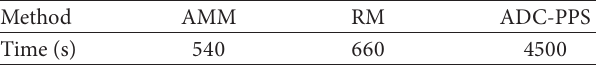
Table 1: Time needed for stroke detection for the three cases of initial guesses, in a PC with 2.66 GHz and 3.25 GB RAM. Method AMM RM ADC-PPS Time (s) 540 660